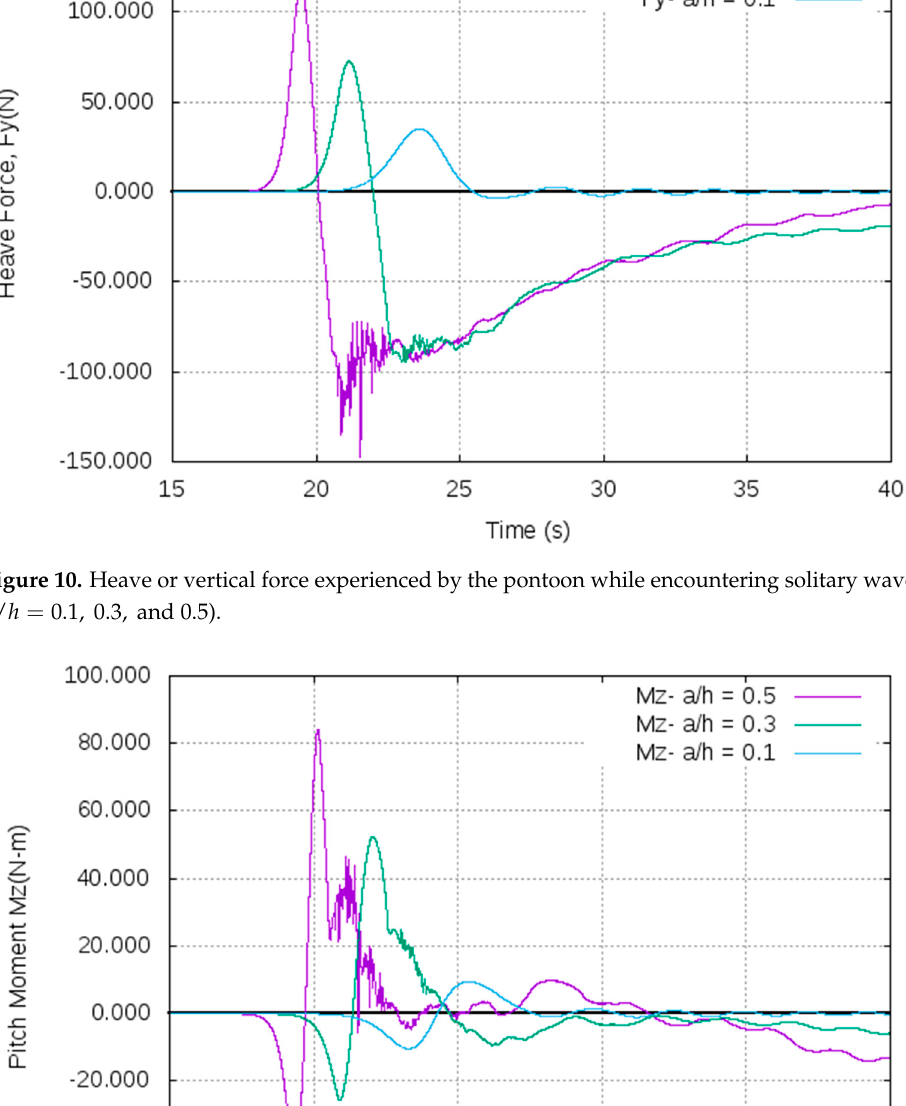
Figure 9. Surge or longitudinal force experienced by the pontoon while encountering solitary wave (for 0.1, 0.3, and 0.5 a h = ).